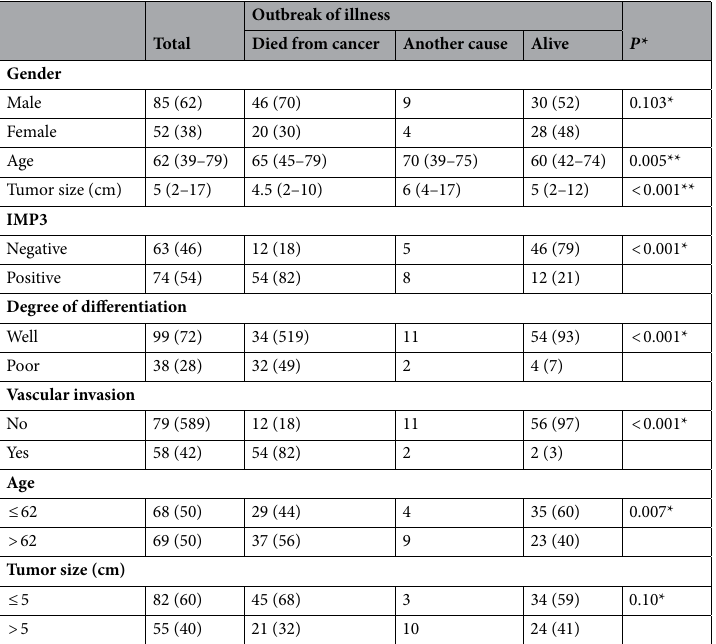
Table 1. The number (%) of patients with CRC and clinical stage II compared to the investigated parameters or median (min–max) of the patients compared to the outcome of the disease. * χ 2 test; †Mann–Whitney U test; ** Kruskal–Wallis